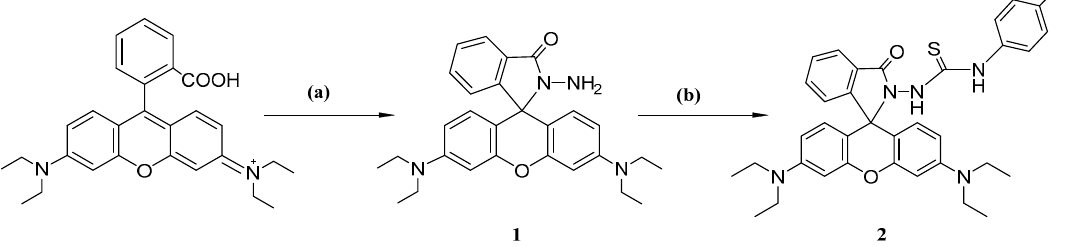
7 of 12 Figure 5. ( a ) Color change of filter paper treated with RB-CT solution (1.0 × 10 − 4 M in CH 3 CN, 3% Et 3 N) and GD in liquid phase under sunlight (left) and UV light (right). ( b ) Color change of filter paper treated with RB-CT solution (1.0 × 10 − 4 M in CH 3 CN, 3% Et 3 N) and exposed to GD in gas phase under sunlight (left) and UV light (right). 3. Materials and